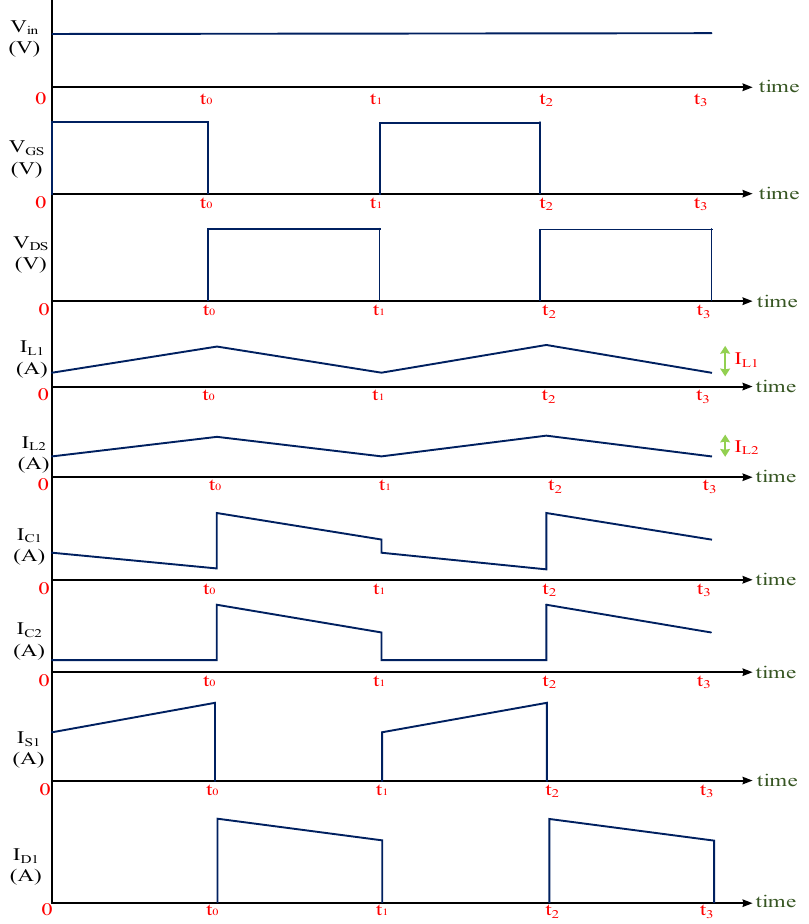
Figure 3. Current and voltage waveforms of a conventional SEPIC converter. Figure 3 demonstrates the converter switching waveforms. V in is the input voltage across the power MOSFET S 1 when it is turned on and o ff . I S 1 represents current across the power MOSFET S 1 , I C1 represents current across the coupling capacitor, and I L1 and I L2 inductor currents build linearly. I D1 is the diode current, I C1 is the current through the cou- pling capacitor, and I C2 is the current through the output capacitor.